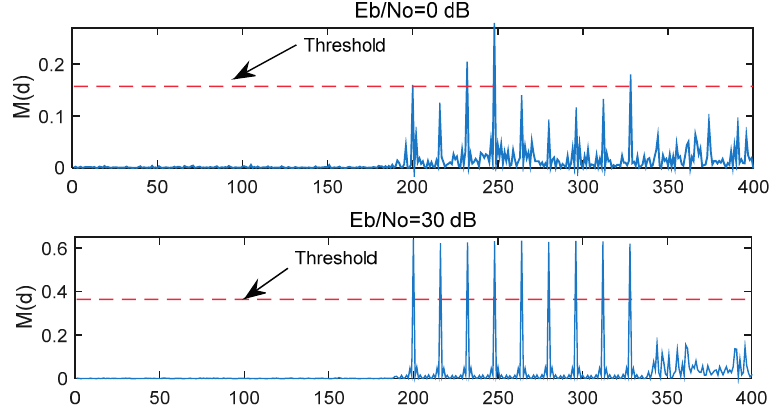
Figure 4. M ( d ) of MathWorks method in different E b / N 0 .